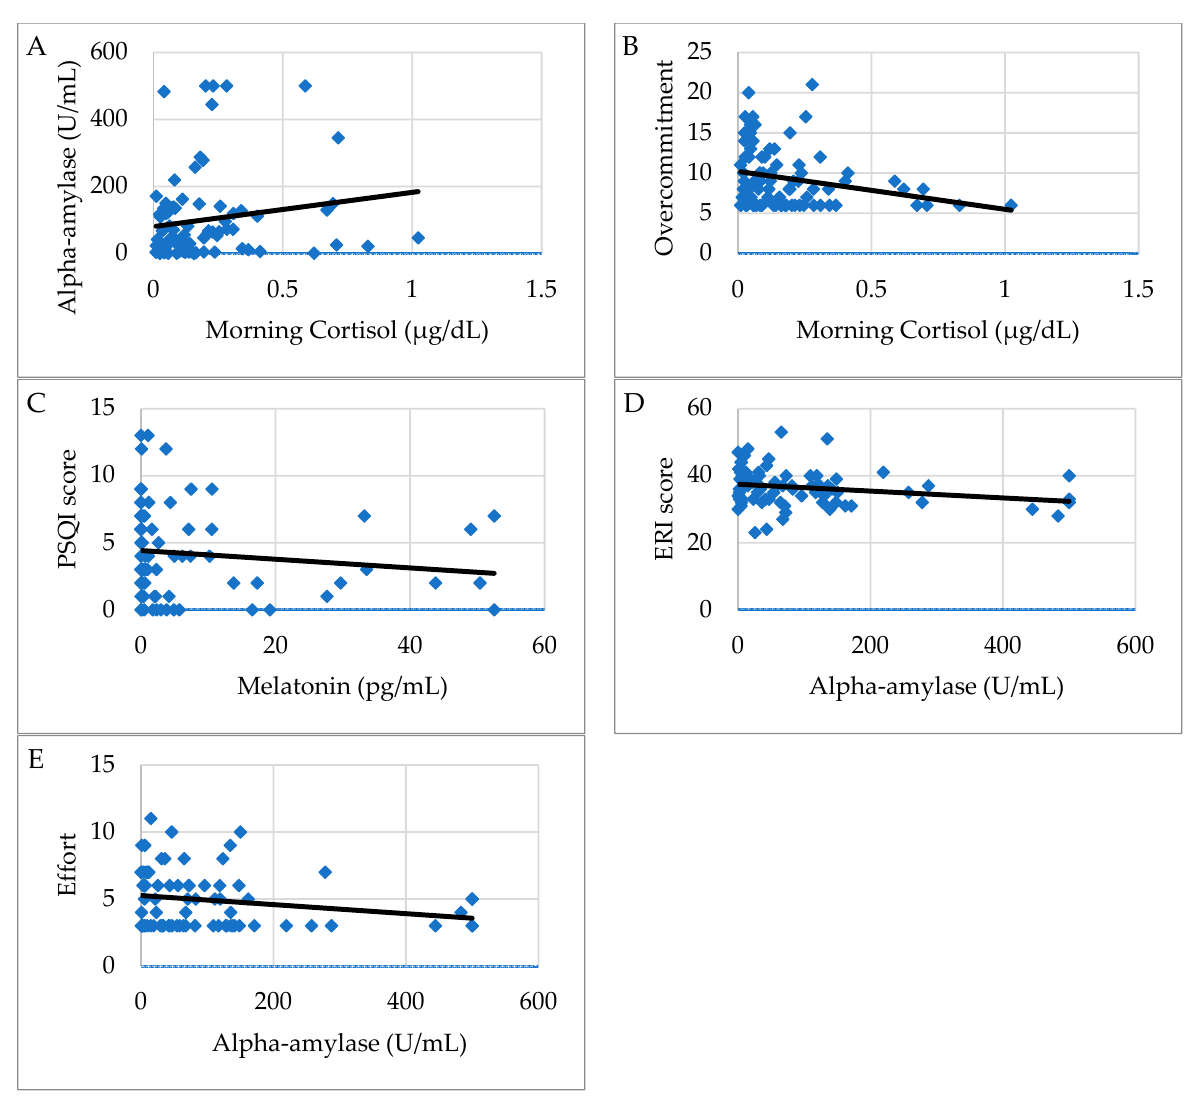
Figure 1. ( A – E ). Graphic representation of correlations between questionnaire scores and salivary biomarkers in dock workers. Figure shows the association of morning cortisol levels with α -amylase ( A ) and overcommitment scale of ERI ( B ), of salivary melatonin with Pittsburgh sleep quality index (PSQI) score ( C ), of α -amylase concentration with Effort reward imbalance (ERI) total score ( D ) and effort scale ( E ).